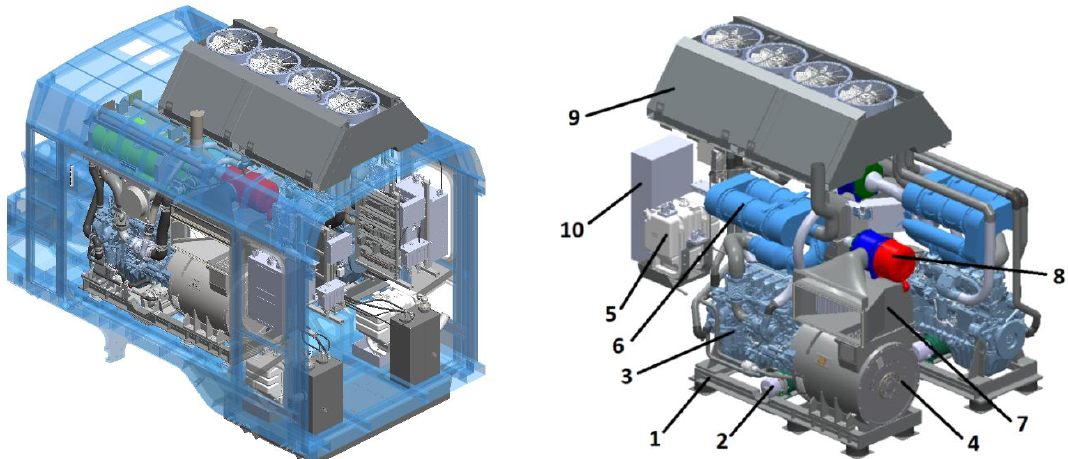
Fig. 16. Left: Machine room. On the right: components of the combustion generator: 1 – generator frame, 2 – heater, 3 – combustion engine, 4 – traction generator, 5 – AdBlue tank, 6 – exhaust aftertreatment system with mufflers, 7 – ventilation duct of the traction generator, 8 – intake air filter with a duct,